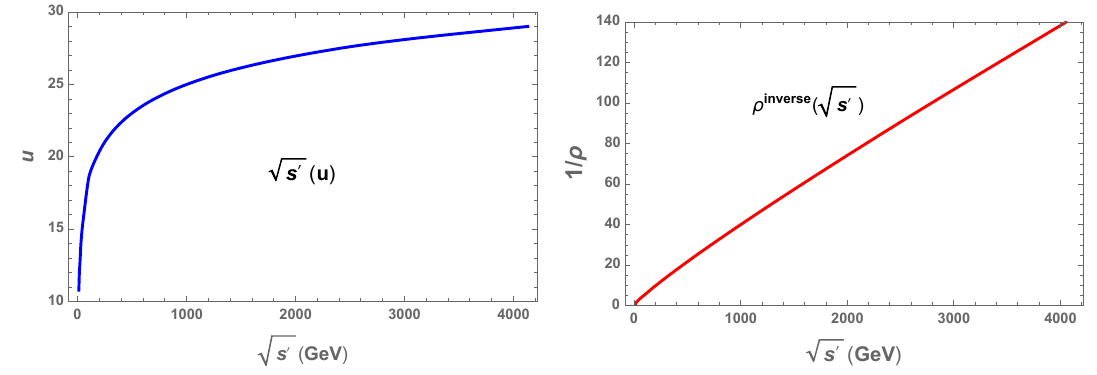
p Figure 4 . The plot on the left shows s 0 measured in GeV and the function of the input variable u . The plot on the right gives the inverse instanton size (in GeV) as the function of energy.